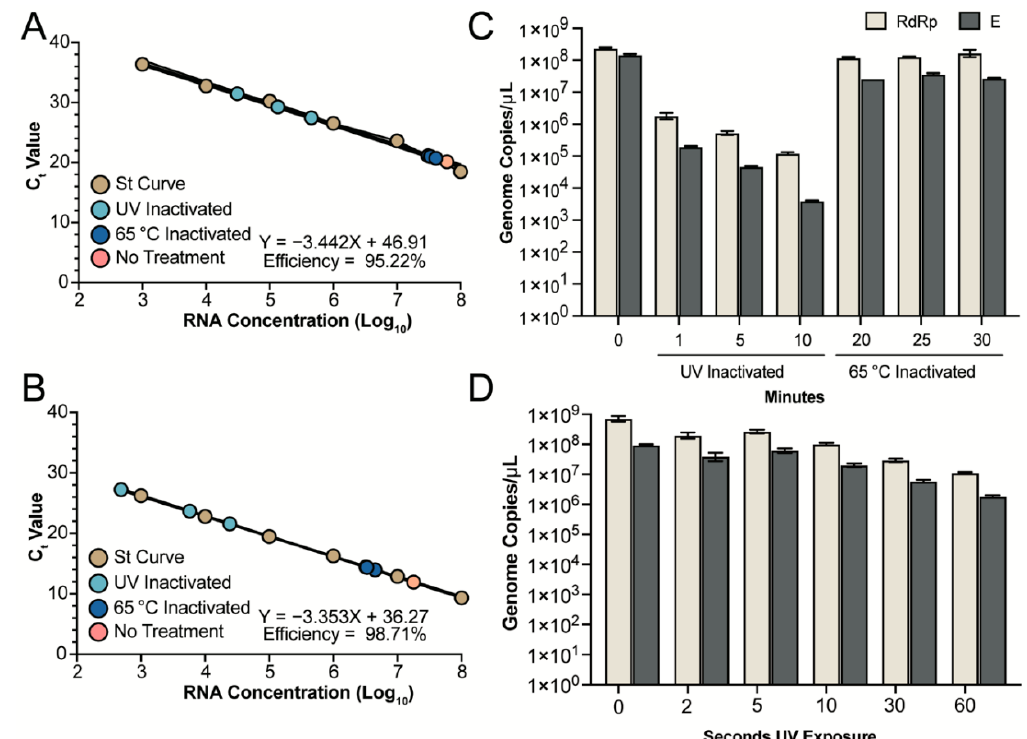
Figure 2. Detection of RNA genomes following inactivation. Inactivated viral supernatants were subjected to RNA extraction and detection. ( A , B ) A standard curve was produced for the RdRp ( A ) and E ( B ) assays using serial diluted in vitro transcribed RNA (brown circles). RNA from UV and heat inactivated samples (light blue and dark blue, respectively) fall within the linear detection of both assays. The untreated genomic RNA is represented by the pink circle. ( C ) Quantification of the untreated RNA, UV inactivated samples at 1, 5 and 10 min and heat inactivated samples at 20, 25 and 30 min are shown. The mean and SEM from triplicate wells for the RdRp (tan) and E (grey) assays are shown. Samples inactivated via UV-C exposure for 1, 5, or 10 min were exposed to 4 × 10 5 , 2 × 10 6 , and 4 × 10 6 µJ/cm 2 , respectively. ( D ) Quantification of untreated RNA and UV inactivated samples at 2, 5, 10, 30 and 60 s for the RdRp (tan) and E (grey) assays.